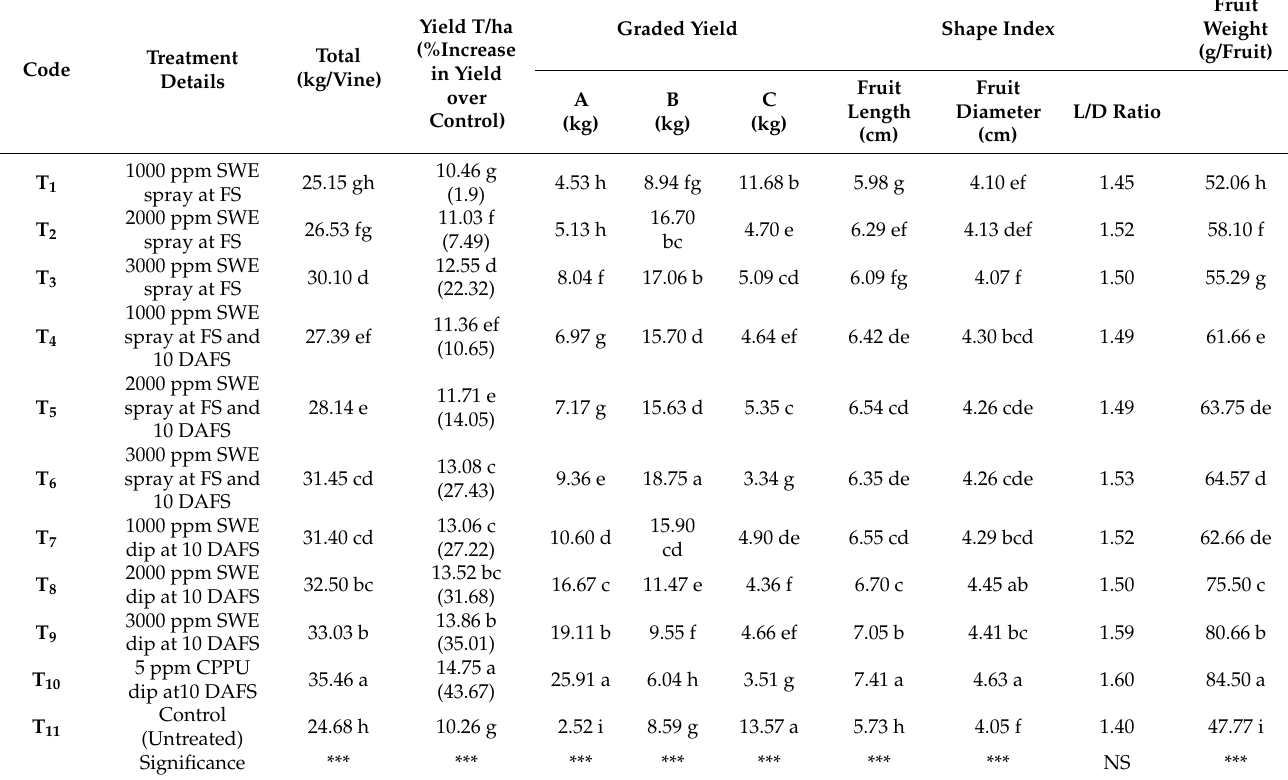
Table 2. Effect of seaweed extract on total fruit yield in